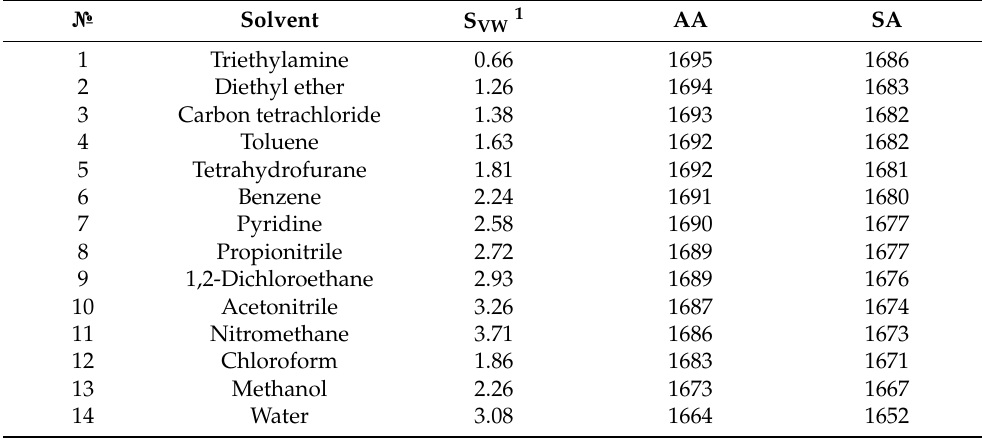
Figure 2. IR spectra of the C=O group of sarcosine anhydride in solvents: 1—tri-ethylamine; 2—diethyl ether; 3—tetrahydrofuran; 4—acetonitrile; 5—nitromethane. Frequencies of the stretching vibrations of C=O groups of alanine anhydride and sarcosine anhydride in solvents are presented in Table 1. The S VW parameter of solvents was taken from [16]. Table 1. Absorption frequency of the C=O stretching vibrations of alanine anhydride (AA) and sarcosine anhydride (SA) in solvents (cm − 1 ) with parameter S VW (kJ 1/2 · cm − 3/2 · 10 − 2 ). № Solvent S № VW